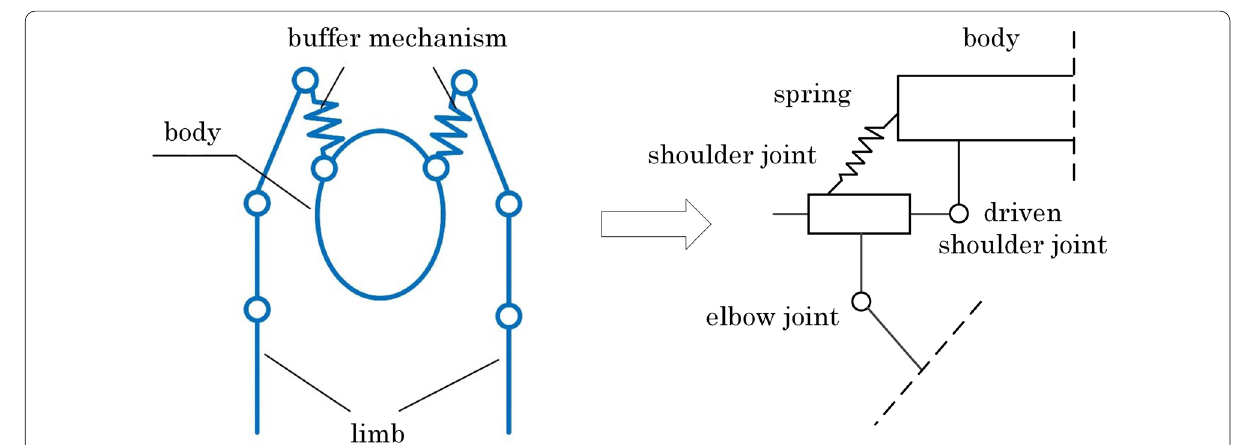
Figure 11 Original structural sketch of the second-stage buffer